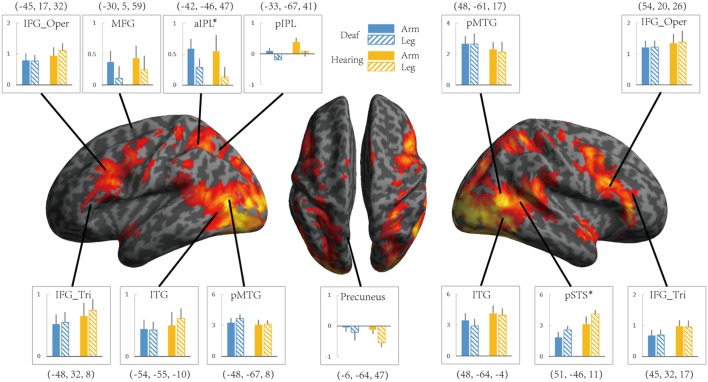
The effect of the Effector for Action Observation in Experiment 2. Areas recruited during action observation (contrast Action Observation > Fixation baseline) in Experiment 2 for all participants (FDR q < 0.05). ROIs were defined in Experiment 1 by the contrast Action Judgment Task > Red Dot (FWE P < 0.05). Colors and symbols are the same as in Figure 3.